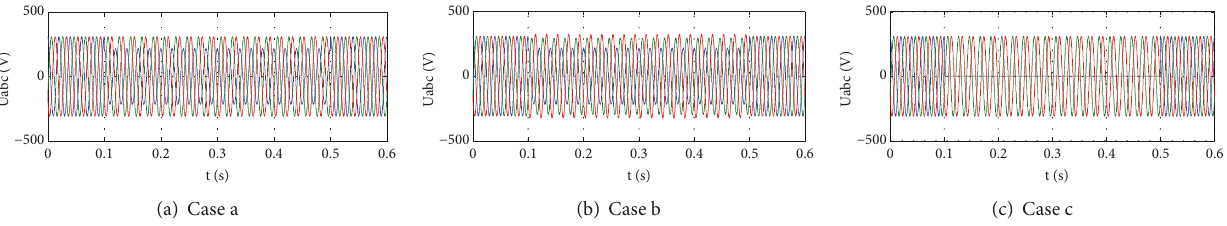
Figure 11: The unbalanced grid voltages in different cases.